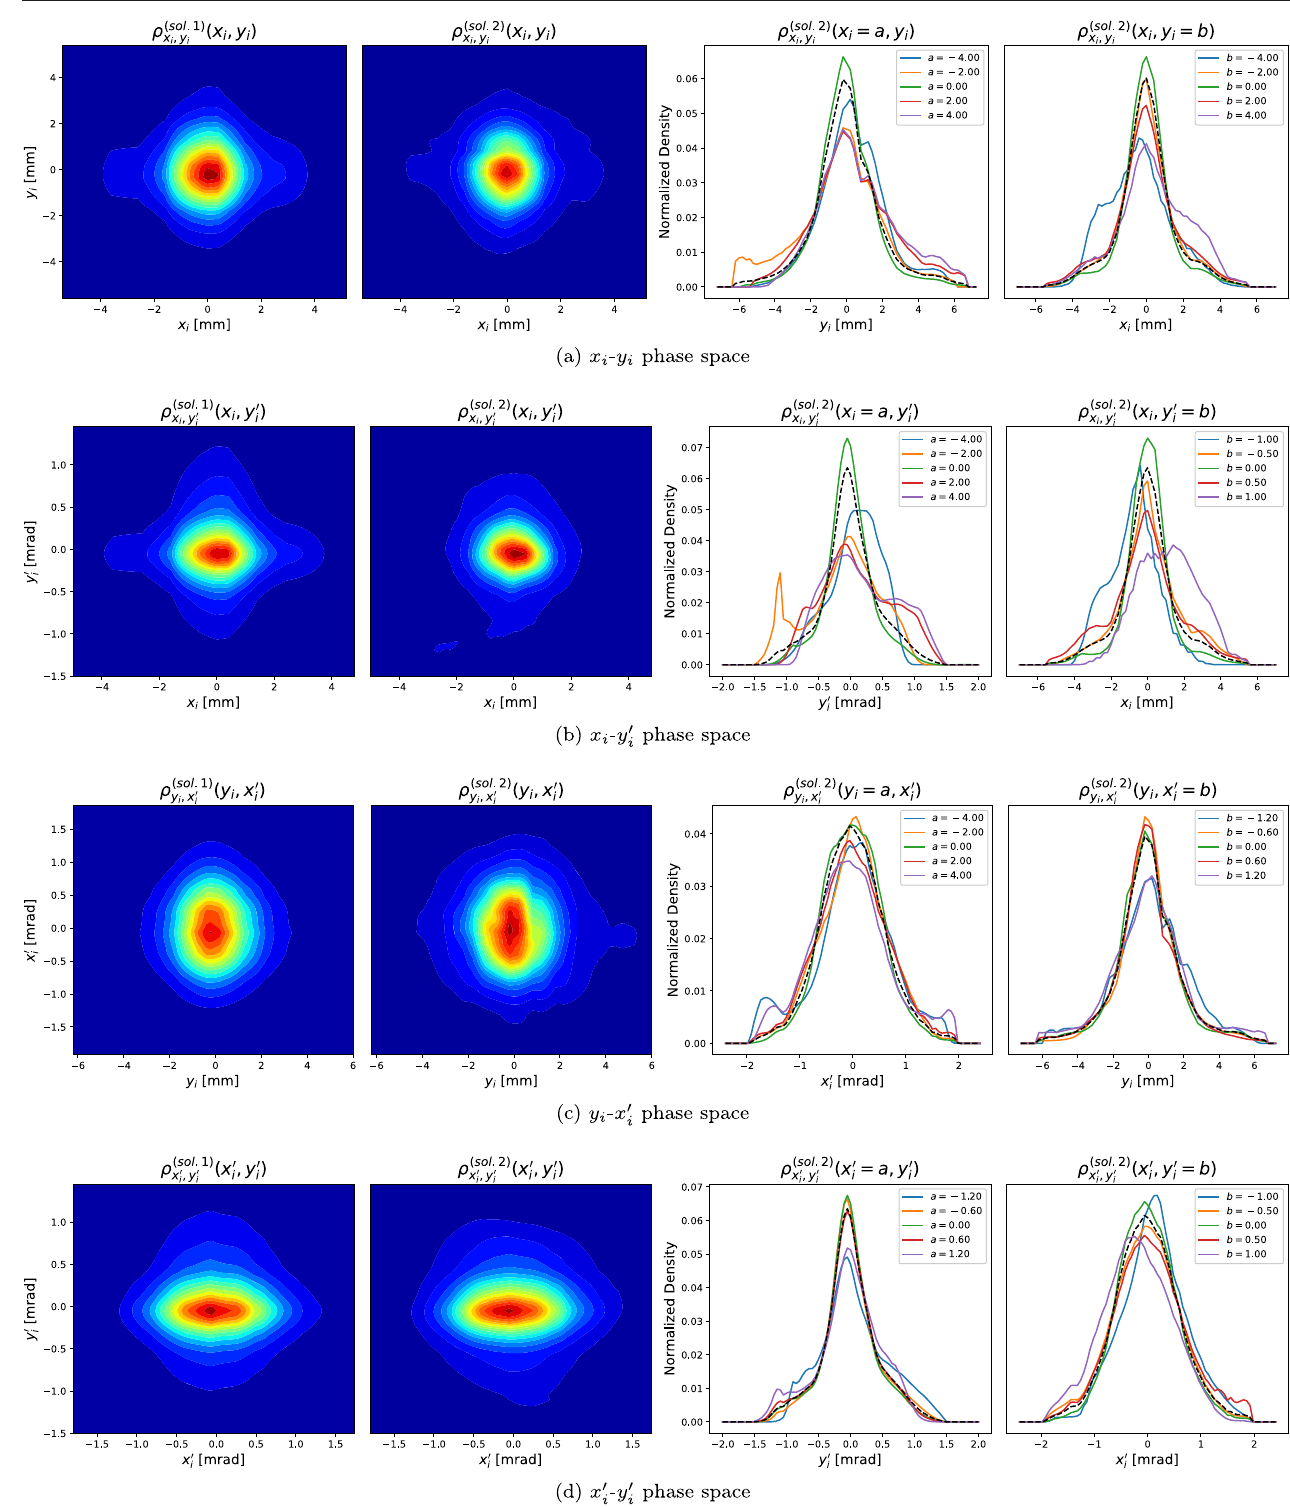
FIG. 4. Cross-plane 2D phase space projections of the 4D MENT numerical solution obtained from four 2D projections at the SNS HEBT laser wire station. The superscript sol 1 denotes the two-scan (parallel slits only) MENT solution, and sol 2 denotes the four-scan (both parallel and perpendicular slits) MENT